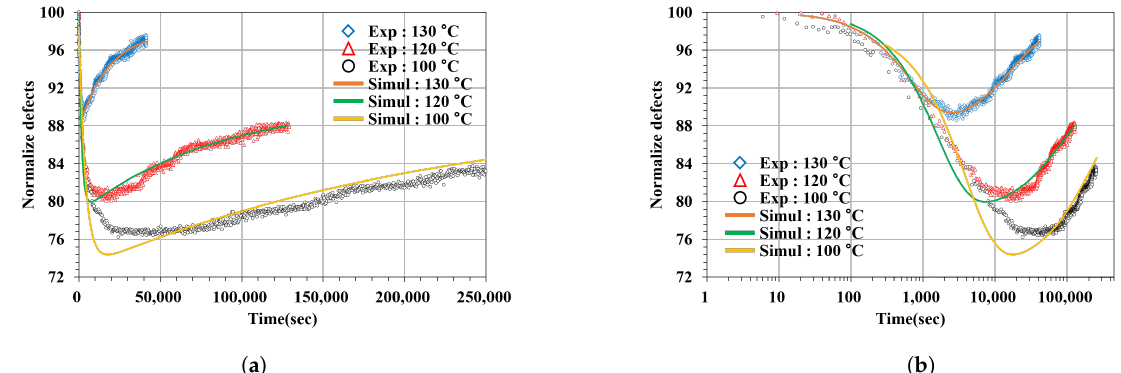
Figure 6. Comparison between the real-time observation results of the LID process of the solar module and the kinetics simulation results of the cyclic reaction model: ( a ) linear scale time result and ( b ) log scale time result.